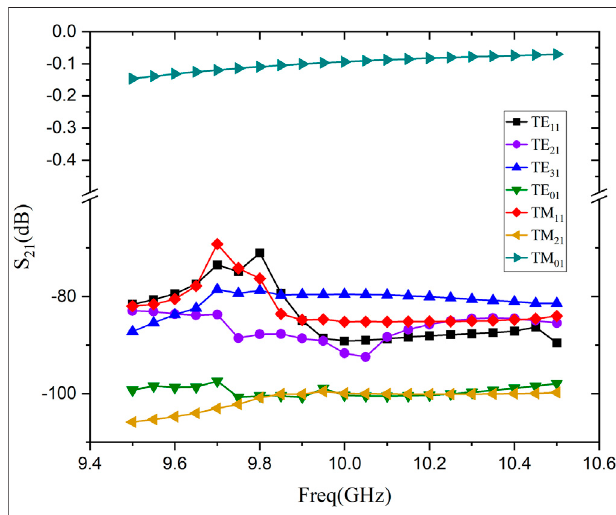
FIGURE 3 | Simulated S 21 for each transmission mode in rotary joint.